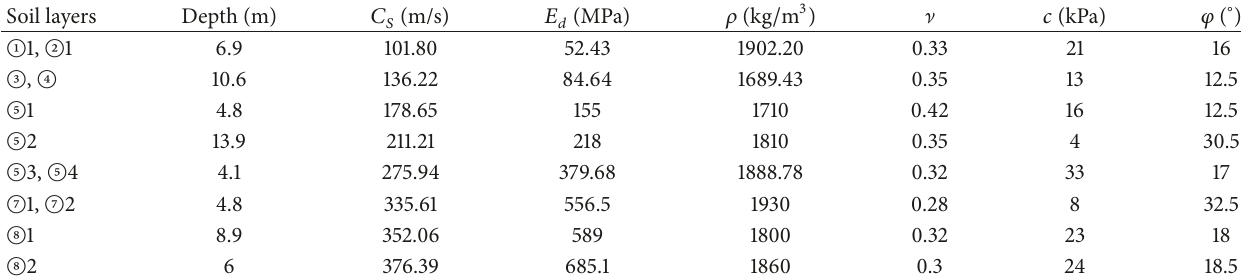
Table 2: Parameters of Shanghai soil.